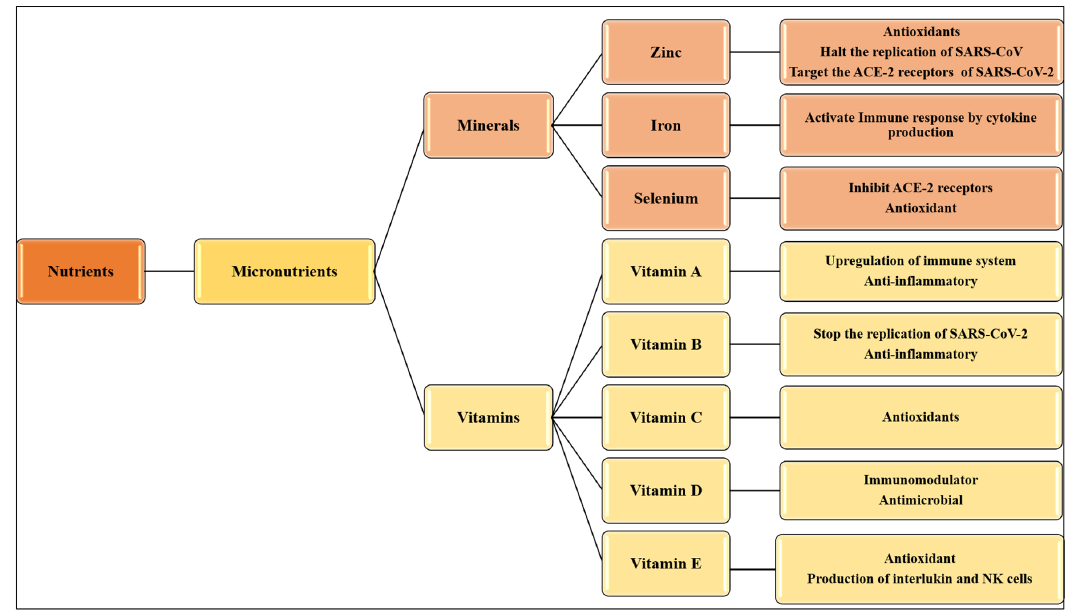
Figure 2. Mechanism of action of micronutrients against CoVs. NK = natural killer; ACE-2 = angiotensin-converting enzyme 2.